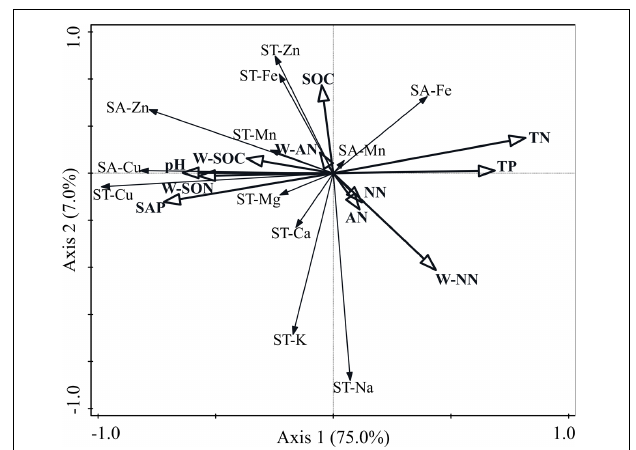
FIGURE 4 | Bi-dimensional graph for the redundancy analysis indicating the relationships between soil macro- and micronutrient concentrations and soil nutrient variables. SA-Cu, soil available-Cu concentration; SA-Zn, soil available-Zn concentration; SA-Mn, soil available-Mg concentration; SA-Fe, soil available-Fe concentration; ST-Cu, soil total-Cu concentration; ST-Zn, soil total-Zn concentration; ST-Mn, soil total-Mn concentration; ST-Fe, soil total-Fe concentration; ST-K, soil total-K concentration; ST-Na, soil total-Na concentration; ST-Ca, soil total-Ca concentration; ST-Mg, soil total-Mg concentration; SOC, soil organic-carbon concentration; TN, total-nitrogen concentration; TP, soil total-phosphorus concentration; SAP, soil available-phosphorus concentration; NN, soil nitrate-nitrogen concentration; AN, soil ammonium-nitrogen concentration; W-SOC, soil water-soluble organic-carbon concentration; W-NN, soil water-soluble nitrate-nitrogen concentration; W-AN, soil water-soluble ammonium-nitrogen concentration; W-SON, soil water-soluble organic-nitrogen